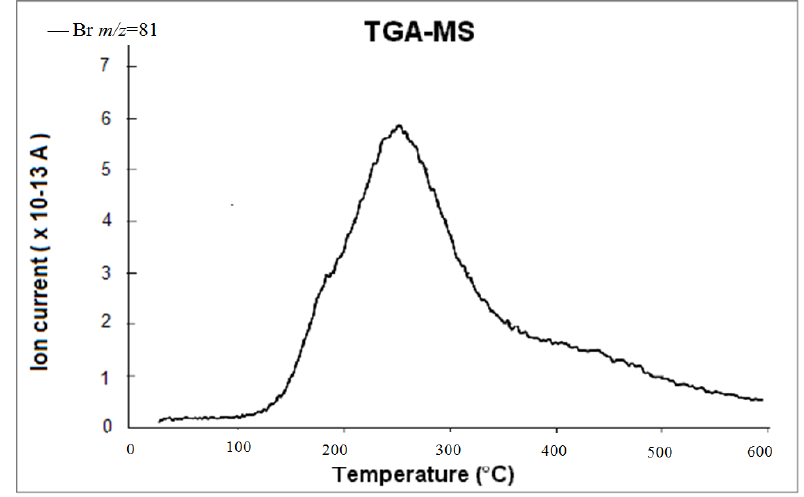
Figure 15. Temperature dependent mass selective ( m/z = 81) ion current in TGA-MS analysis of sample